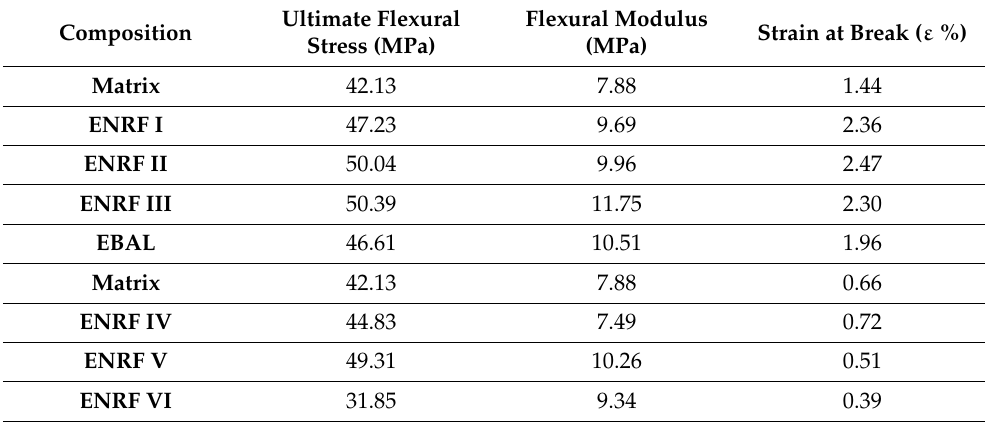
Table 6. Mechanical properties of the epoxy-rubber based composites reinforced with GBs, boron, and Fe 3 O 4 [34,35].